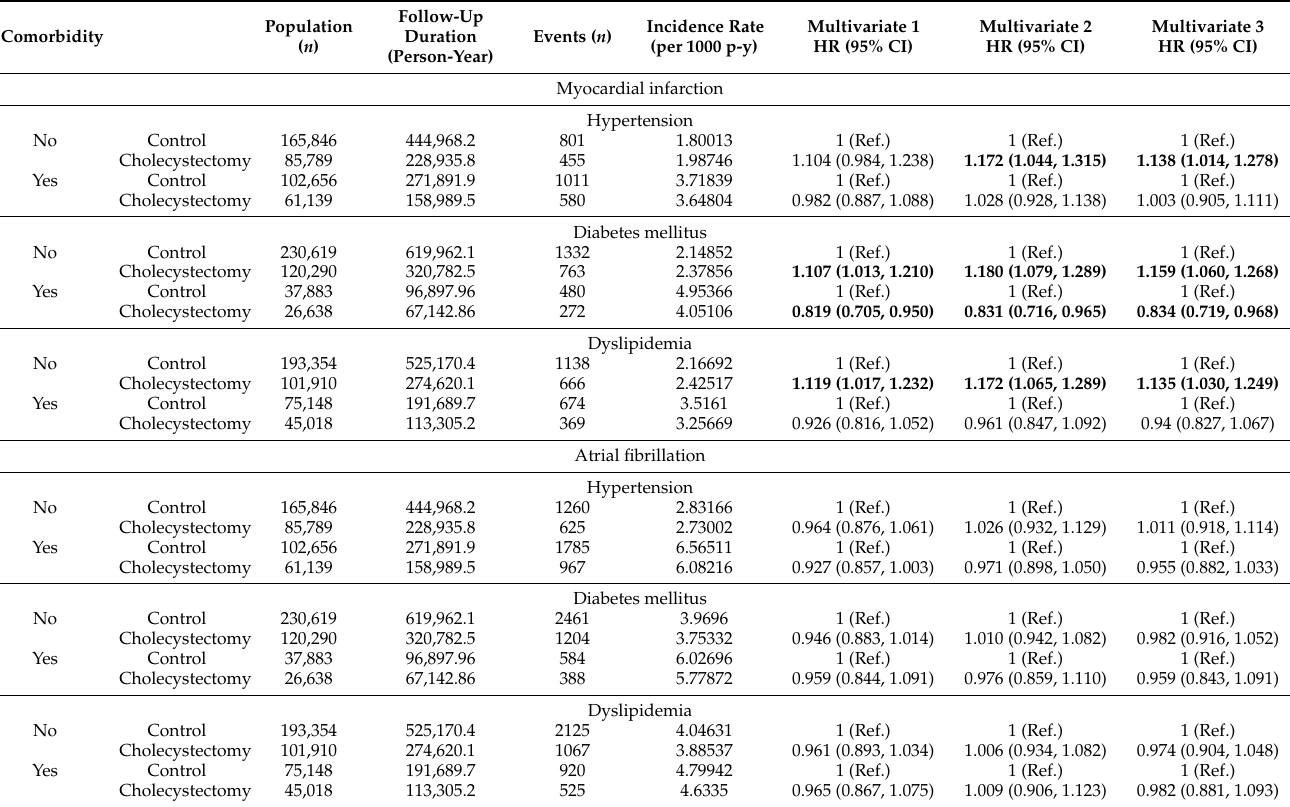
Table 5. Incidence of myocardial infarction, atrial fibrillation, and congestive heart disease in the cholecystectomy and control groups according to